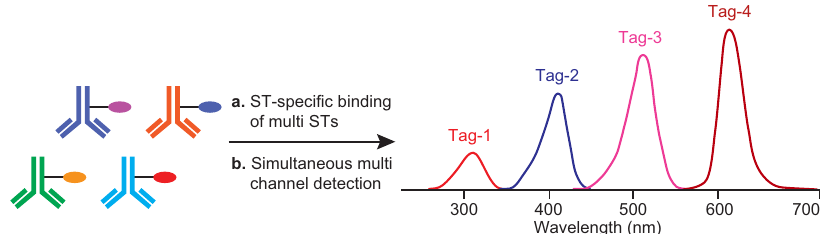
Fig. 4 Analysis of multi-valent PCV on the multiplex chromatography assay platform with fl uorescent (FLR) tag-labeled antibodies. Each of the four antibodies was labeled with a distinctive FLR tag. On HPLC, the detection was set on the speci fi c Ex/Em wavelength unique to the tag. The CRM protein on the conjugate was not labeled.